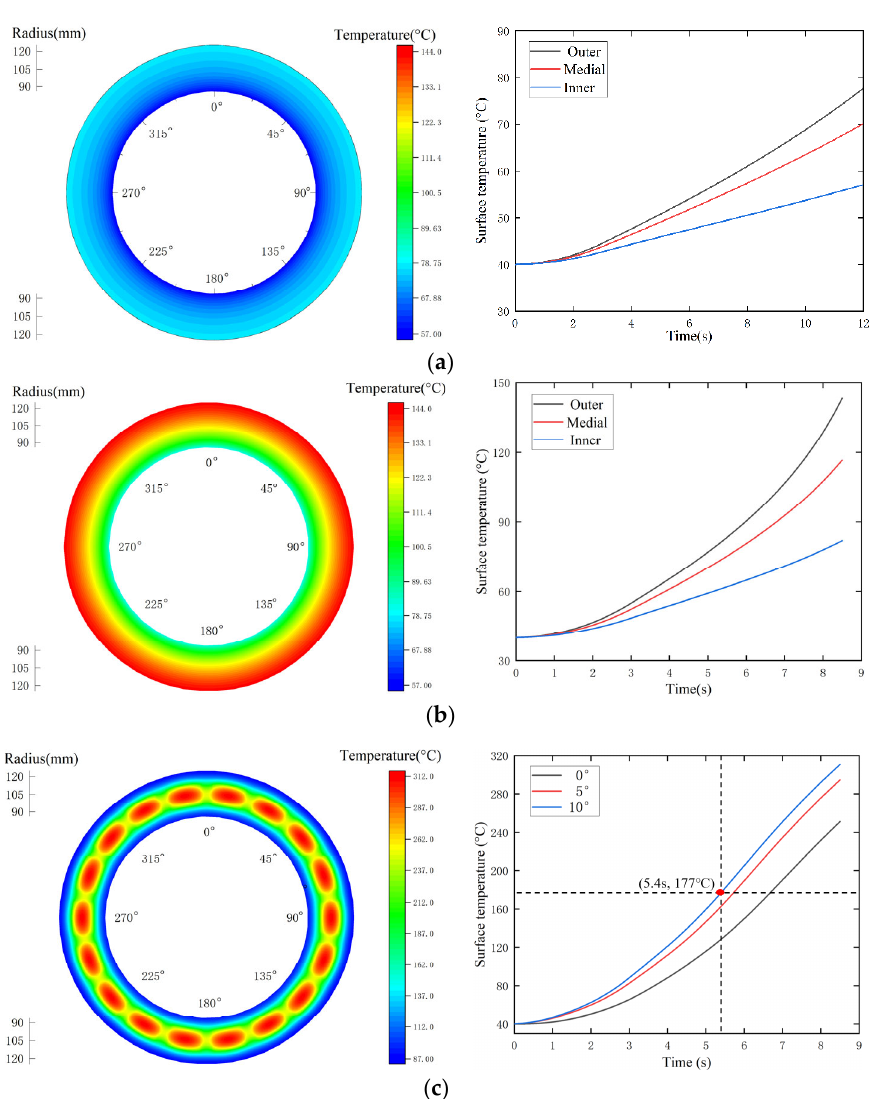
Figure 5. Simulation results for the surface temperature. ( a ) Test 1 (UCS); ( b ) Test 5 (UCS); ( c ) Test 5 (ICS).